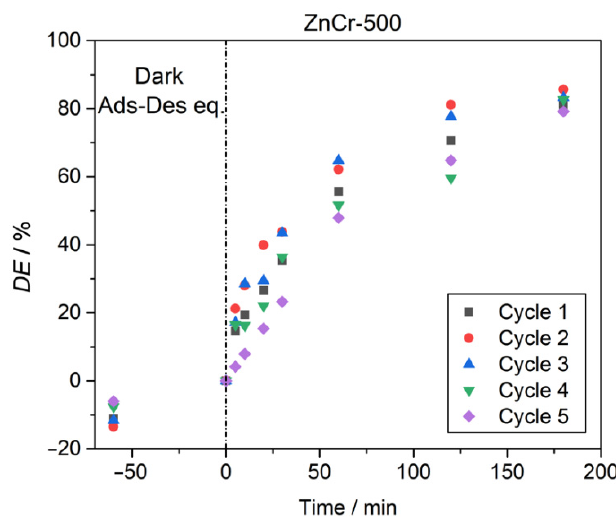
Figure 13. Cyclic degradation of CV dye by using ZnCr-500 catalyst.